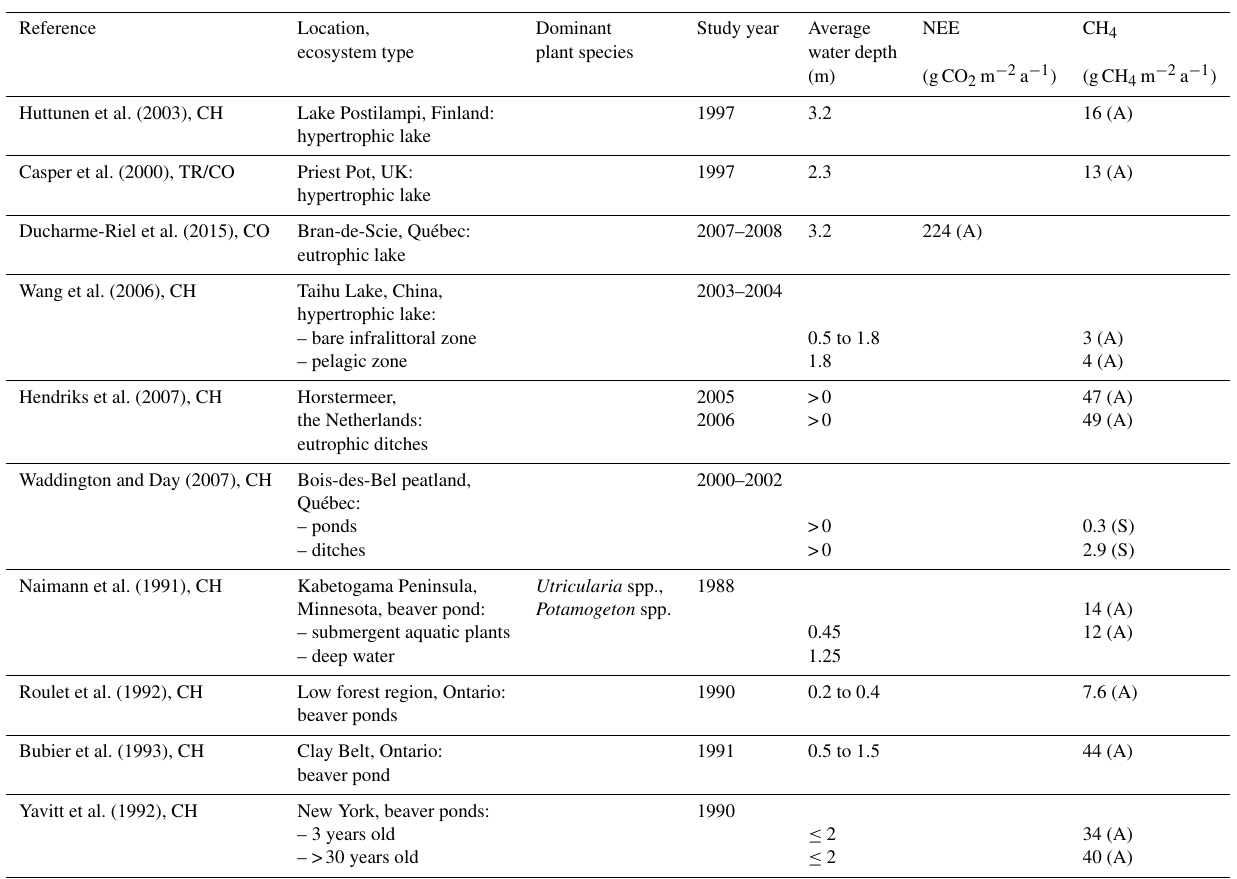
Table 4. NEE and net CH 4 exchange at open water sites. The letters in parentheses indicate seasonal (S; May to October) and annual (A) budgets. Positive water level indicates inundated conditions. GHG flux measurement methods are denoted as CH for chambers, CO for concentration profiles and TR for gas